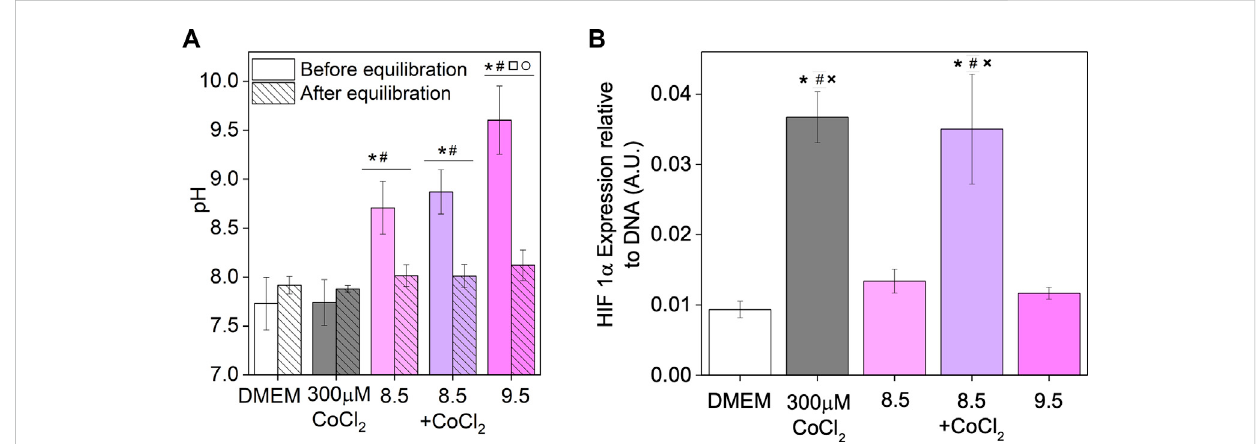
FIGURE 6 EffectofpHonHIF-1 α expression:pHofDMEMmediabeforeandafterequilibrationovernightina5%CO 2 incubator (A) andHIF-1 α measuredwhen exposing keratinocytes to media of elevated pH of 8.5 (with and without cobalt chloride) and 9.5 after equilibration overnight (B) . Data is represented as mean ± standard deviation with N = 3. Statistical signi fi cance was determined with a (A) two way ANOVA or (B) one way ANOVA, with a Tukey means comparisontestwith* p < 0.05comparedtoDMEM,# p < 0.05comparedto300µMCoCl 2 , □ p < 0.05comparedto8.5, ○ p < 0.05comparedto8.5+ CoCl 2 and ✕ p < 0.05 compared to